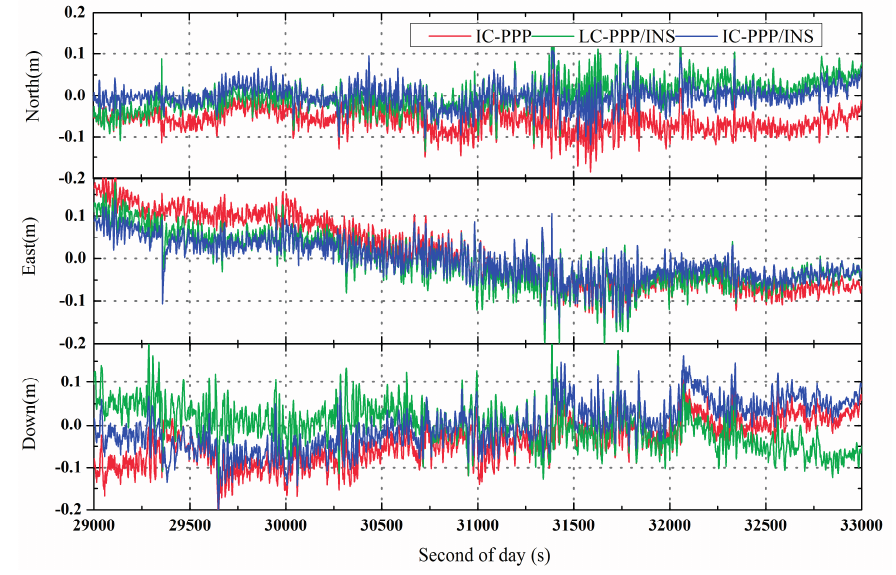
Figure 3. Position differences of IC-PPP ( red line), LC-PPP/INS ( green line), and IC-PPP/INS solution ( blue line) with respect to the reference solution using NovAtel IE